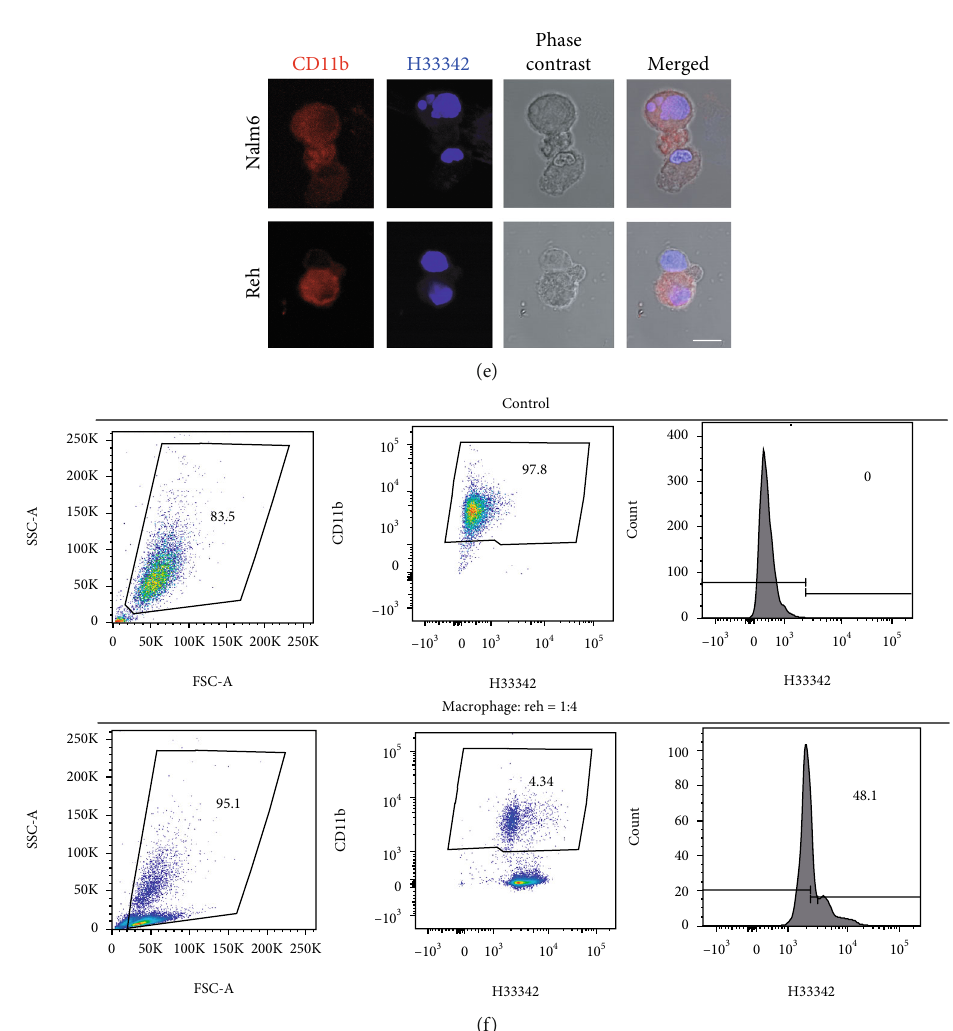
Figure 3: The hiPSC-derived macrophages possess the function of phagocytosis. (a, b) Flow cytometric analysis of the uptake of fl uorescent beads by IPSDMs in two di ff erentiation protocols. (c) Phagocytosis of fl uorescent beads (red) by IPSDMs and IPSCs control. DAPI (blue) shows the cell nuclei; WGA (green) shows the cell membrane. Scale bars, 50 μ m. (d) When the ratio of IPSDMs to tumor cells is 1 :1, 1:2, or 1: 4, the proportion of IPSDMs that have engulfed tumor cells is calculated. All experiments were performed three times. Error bars, SD. (e) Representative images of Nalm6 and Reh cells (labeled with Hoechst 33342) phagocytized by IPSDMs (labeled with CD11b and phase contrast image). Scale bars, 25 μ m. (f) Flow cytometric analysis of phagocytosis of IPSDMs on Reh ( IPSDM : Reh = 1 : 4 ). CD11b + macrophages are gated (middle panel), and V450 intensity is shown as a histogram (right panel). Macrophages cocultured with Reh- Hoechst 33342 suspension (after washing) as a negative